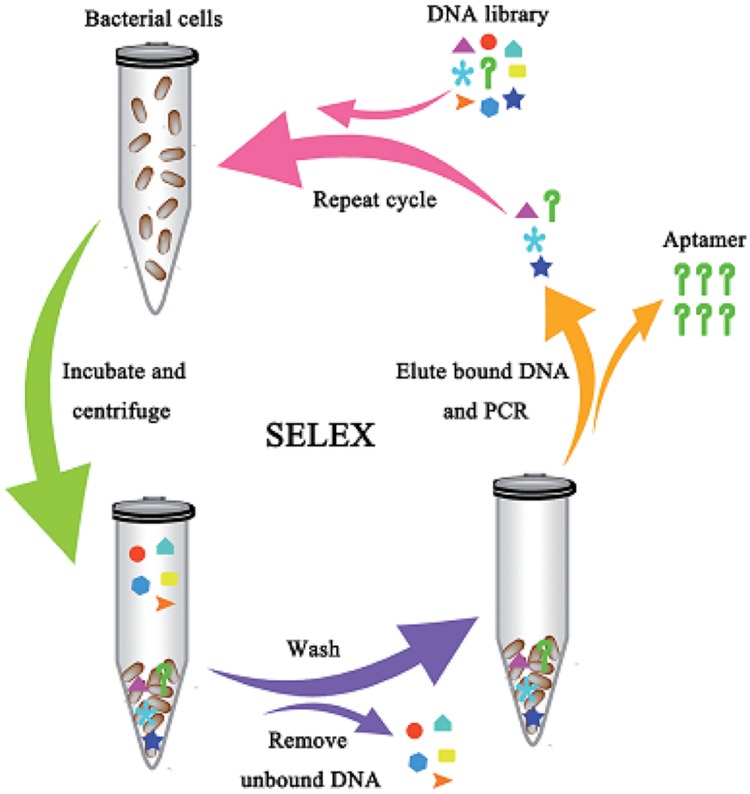
Schematic showing the aptamer selection against live bacterial cells using whole-cell SELEX (Zhang et al., 2015).